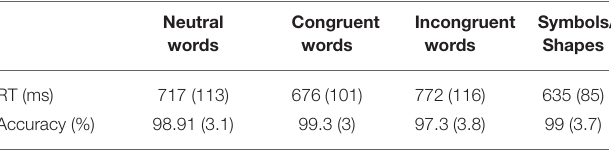
TABLE 1 | Means (standard deviations) of reaction time (RT) and percentage of accuracy of the four conditions.